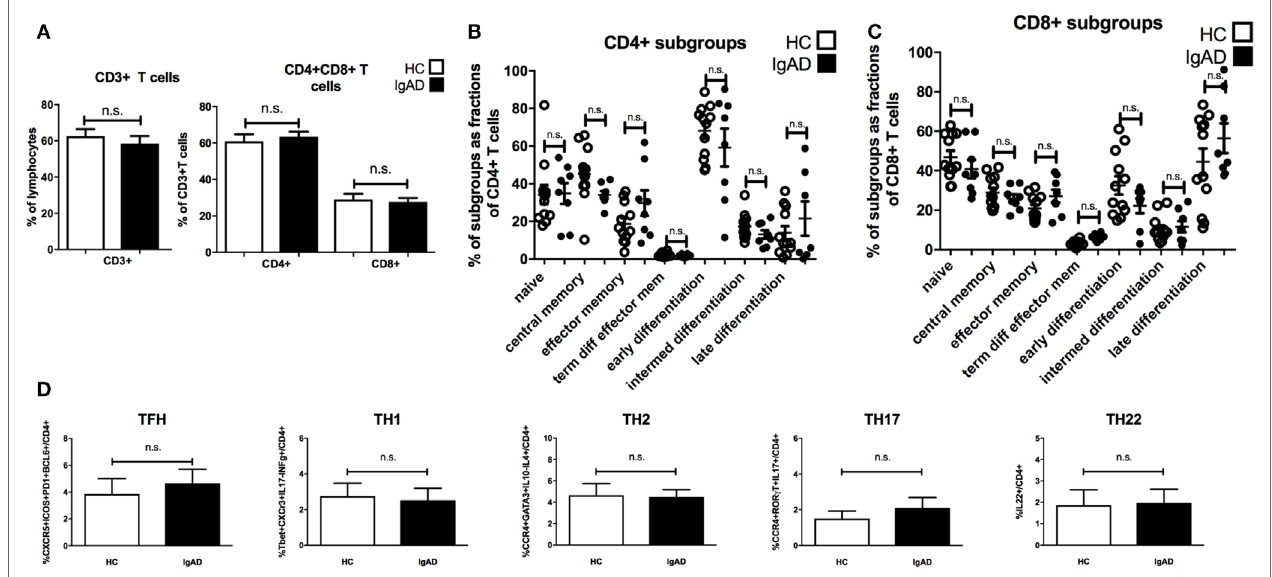
FigUre 4 | The main T cell subsets are of normal proportions in selective IgA deficiency (IgAD). The figure shows T cell populations as measured by flow cytometry on PBMCs for extracellular markers and on PBMCs stimulated with PMA and ionomycin for 4 h comparing IgAD and controls. No significant differences were found for the proportions of T cells. (a) The fraction of CD3 + T cell as proportions of lymphocytes and CD4 + and CD8 + T cells as proportions of CD3 + T cells in IgAD vs. healthy controls (HC). (B) Fractions of the different T cell subpopulations of CD4 + and (c) CD8 + T cells. The subpopulation gating is based on their classification as naïve (CD62L + CCR7 + ), central memory (CD62L − CCR7 + ), effector memory (CD62L − CCR7 − ), terminally differentiated effector memory (CD62L + CCR7 − ), early differentiated (CD27 + CD28 + ), intermediately differentiated (CD27 + CD28 − ), or lately differentiated (CD27 − CD28 − ). (D) The figures show the proportions of T helper cell populations as a fraction of CD4 T cells. No significant differences were seen between T follicular helper cell [CD4 + CXCR5 + ICOS + programmed cell death protein 1 (PD1 + ) B-cell lymphoma 6 protein + ], TH1 (CD4 + T-box transcription factor TBX21 + CXCR3 + IL-17 − IFN γ + ), TH2 [CD4 + CCR4 + trans-acting T-cell-specific transcription factor (GATA3 + ) IL-10 − IL-4 + ], TH17 (CD4 + CCR4 + ROR γ T + IL-17 + ), and TH22 (CD4 + IL-22 + ) cells between IgAD and healthy controls. All data are from five-independent experiments, no duplicates. Significance was calculated in relation to the control group. * p < 0.05, ** p < 0.01, *** p < 0.001 (as determined by one-way